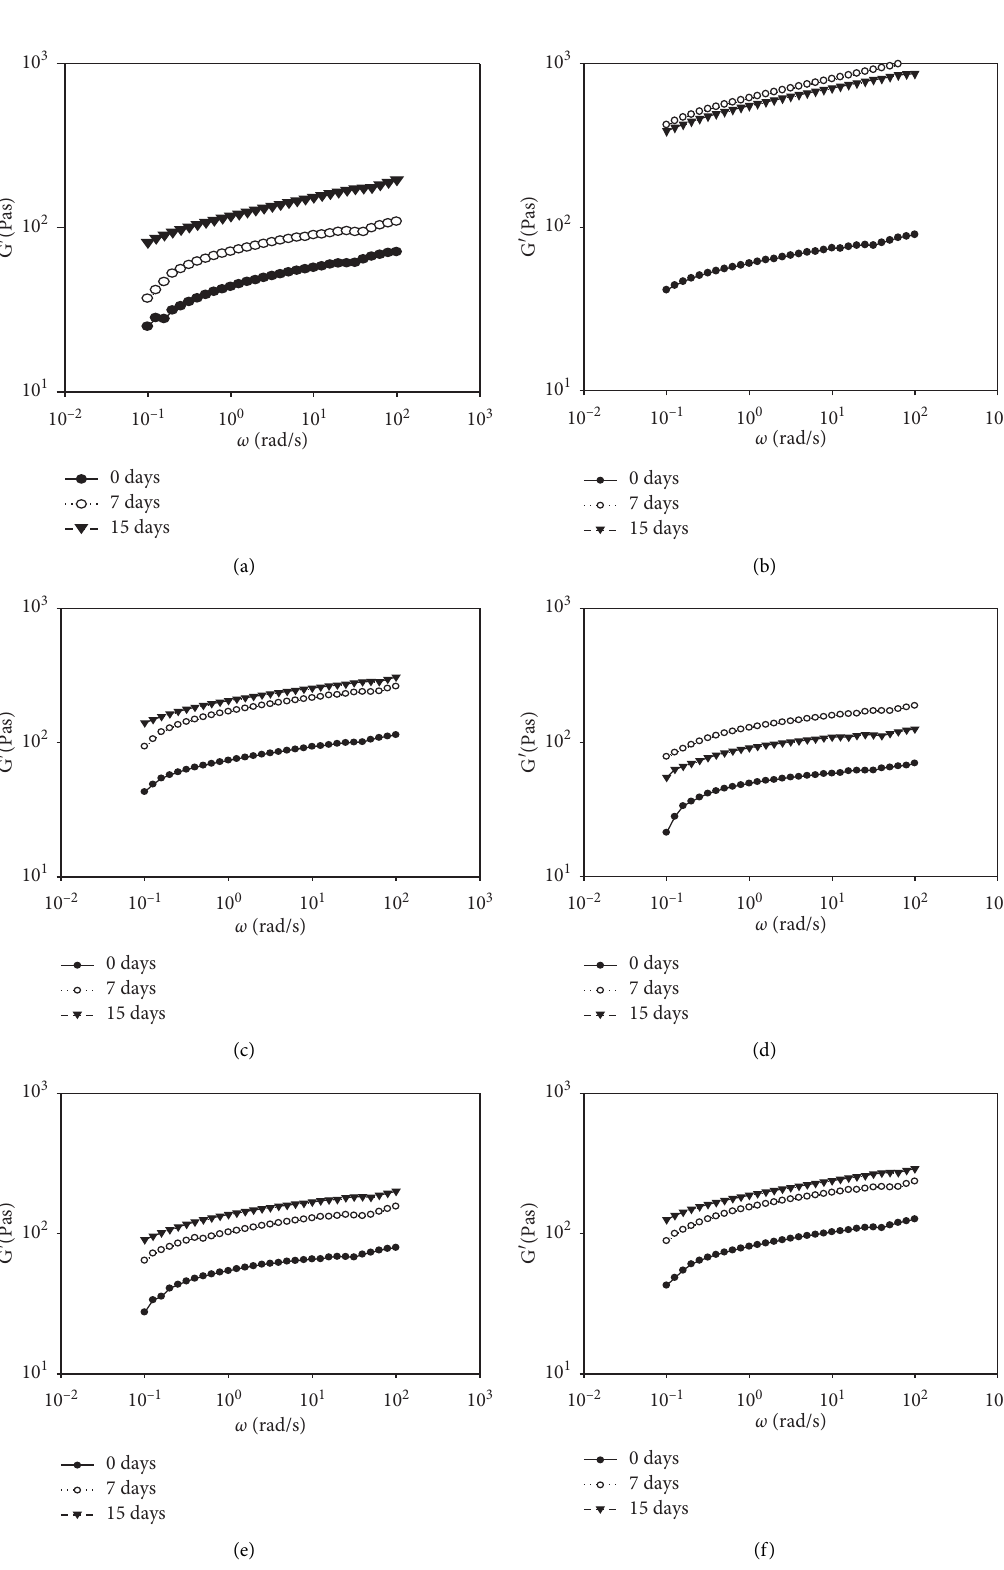
Figure 2: G ′ of yogurt, okra gum, and different starches blend tested at the beginning of cold storage and after 7 or 15 days: (a) control (only okra); (b)chickpea, (c) corn, (d) potato, (e) sweet potato, and (f) Turkish beans